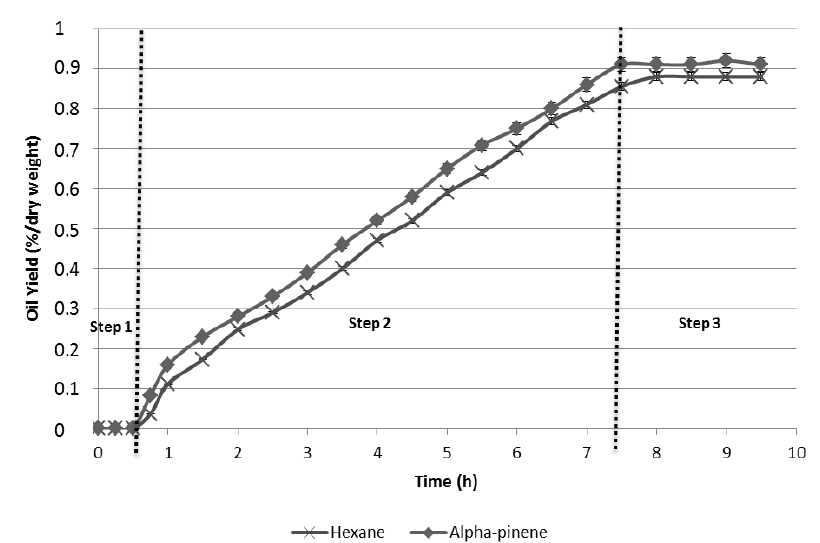
Figure 2. Extraction kinetics.